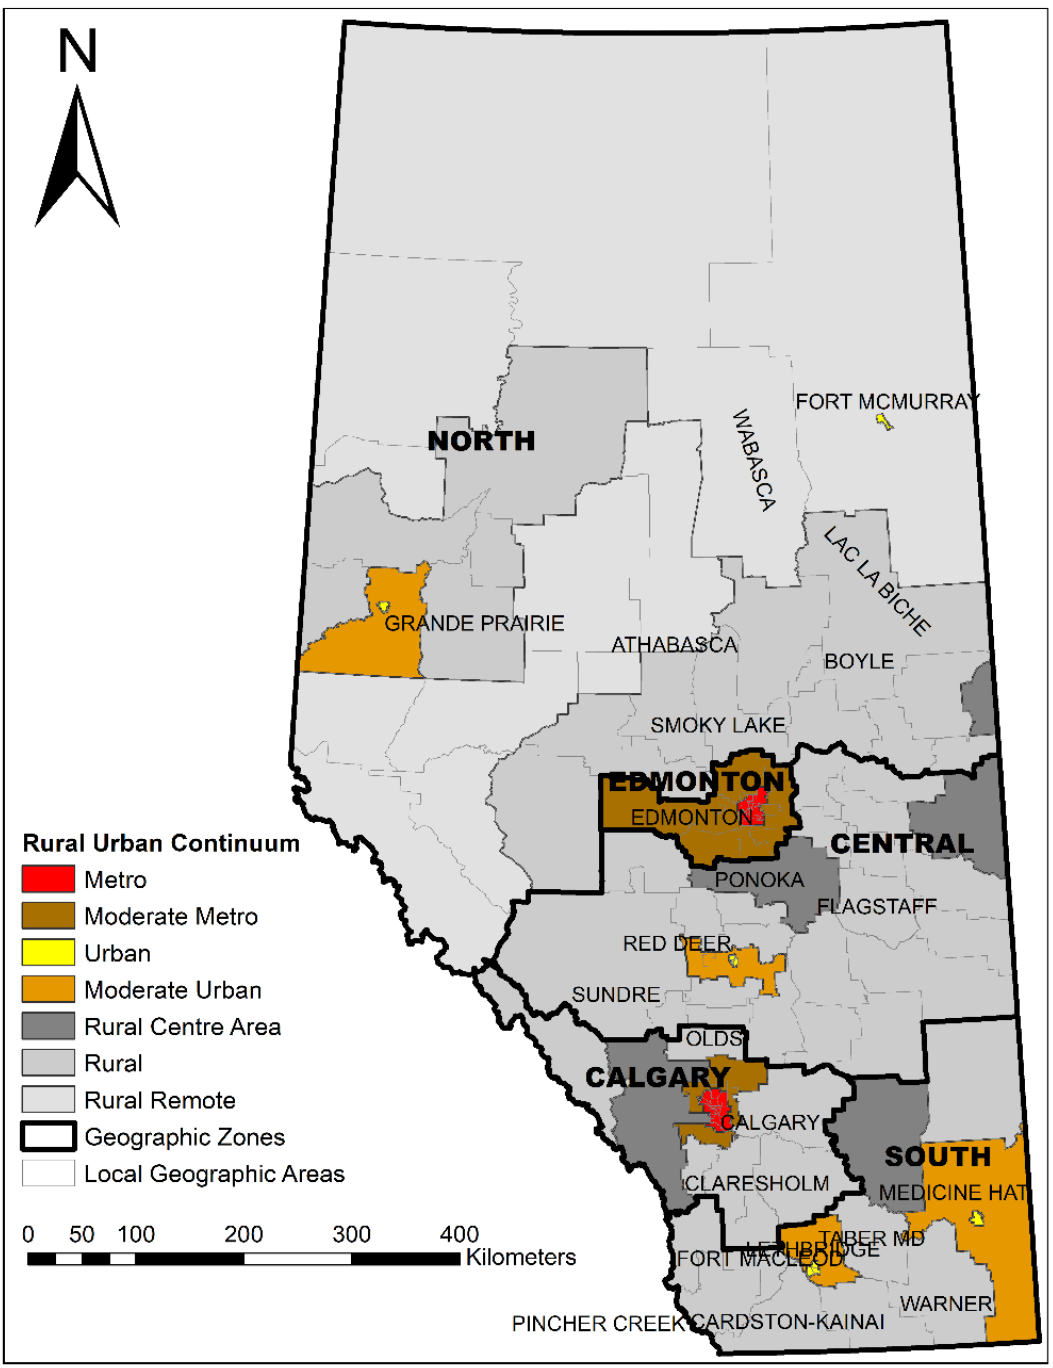
Figure 1. AHS standard geographic areas including a rural–urban continuum, 5 operational zones, and 132 LGAs.